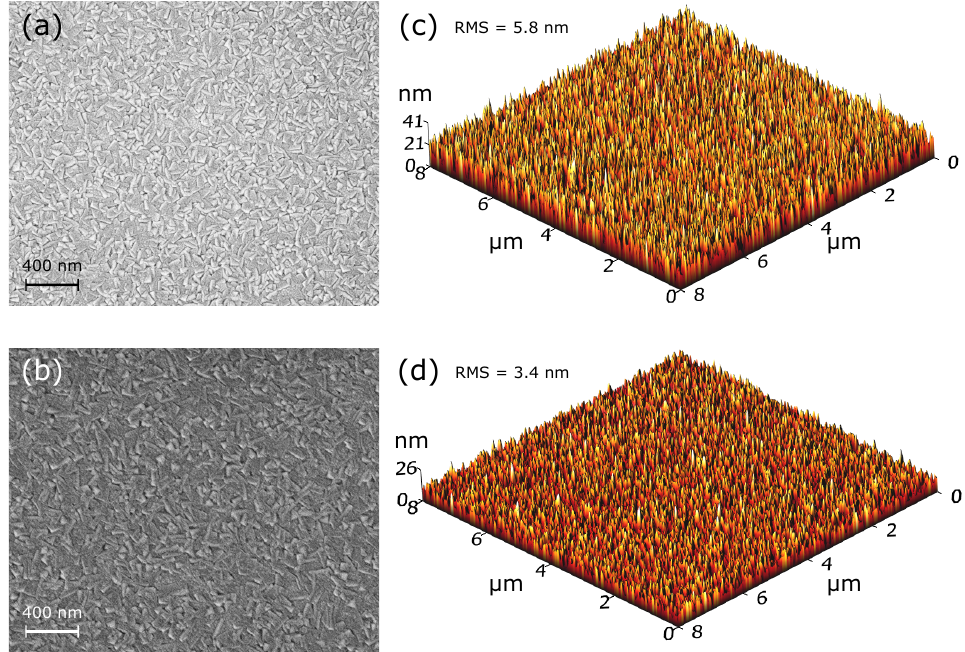
Figure 6. ( Left column) SEM and ( right column) AFM images of the the samples produced at a magnetron power of ( a , c ) 300 W and ( b , d ) 900 W. A processing pressure of 0.2 Pa and an N 2 /Ar ratio of 27% is kept constant. RMS values are given in correspondence to every AFM